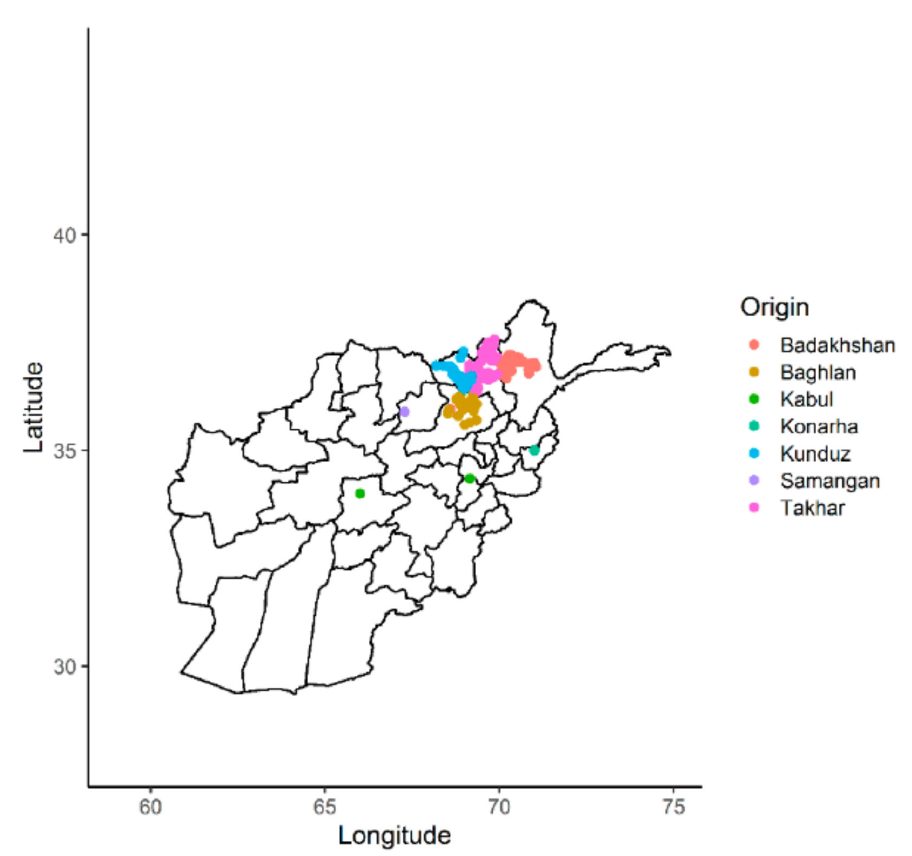
Figure 1. Distribution of the Afghan landraces according to their geographic